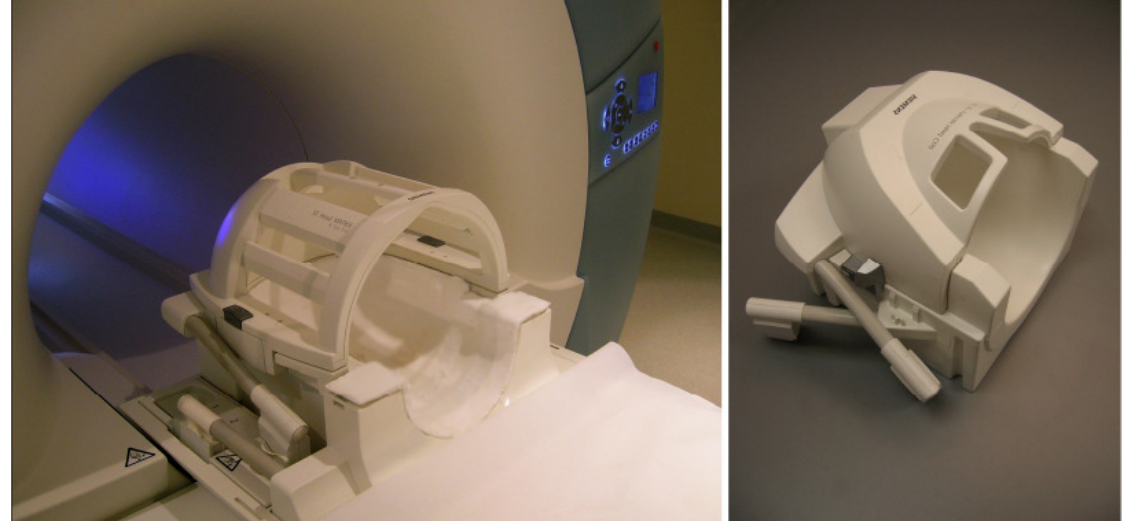
Figure 12. High field whole body MR scanner Siemens TIM Trio (3 Tesla, left) with a 12-channel receive-only head coil (Siemens). A cylindrically polarized (CP) whole body RF coil for transmitting 123 MHz ( 1 H at 3 T) radio frequency signals and B are installed in the scanner bore. Various Rx or local Tx/Rx coils can be used, e.g., a 32-channel receive head coil also by Siemens